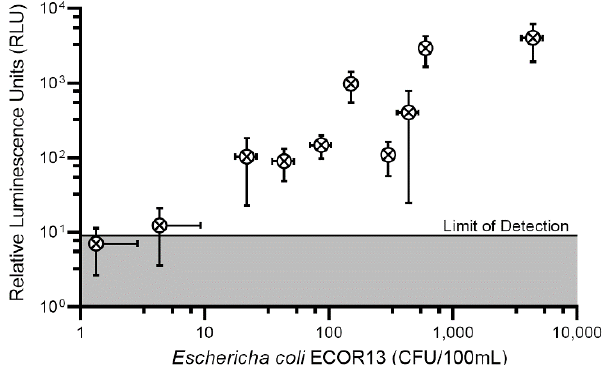
Figure 6. Performance of the phage-based syringe filter detection assay compared to standard plate counts. Water (100 mL) was processed through a syringe filter (0.22 um, regenerated cellulose) where bacteria ( E. coli ECOR13) were enriched prior to the addition of phage NRGp5. Reporter enzymes were expressed, immobilized onto the cellulose filter, and luminescence was measured.